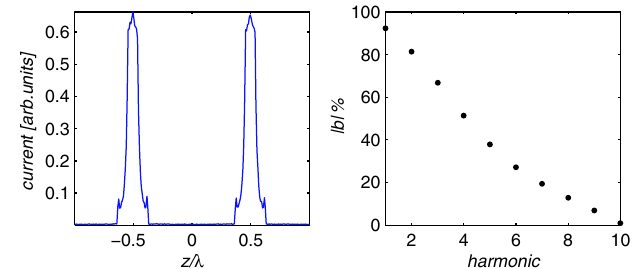
FIG. 13. Current (left) and harmonic bunching factors (right) in the adiabatic bunching scheme.